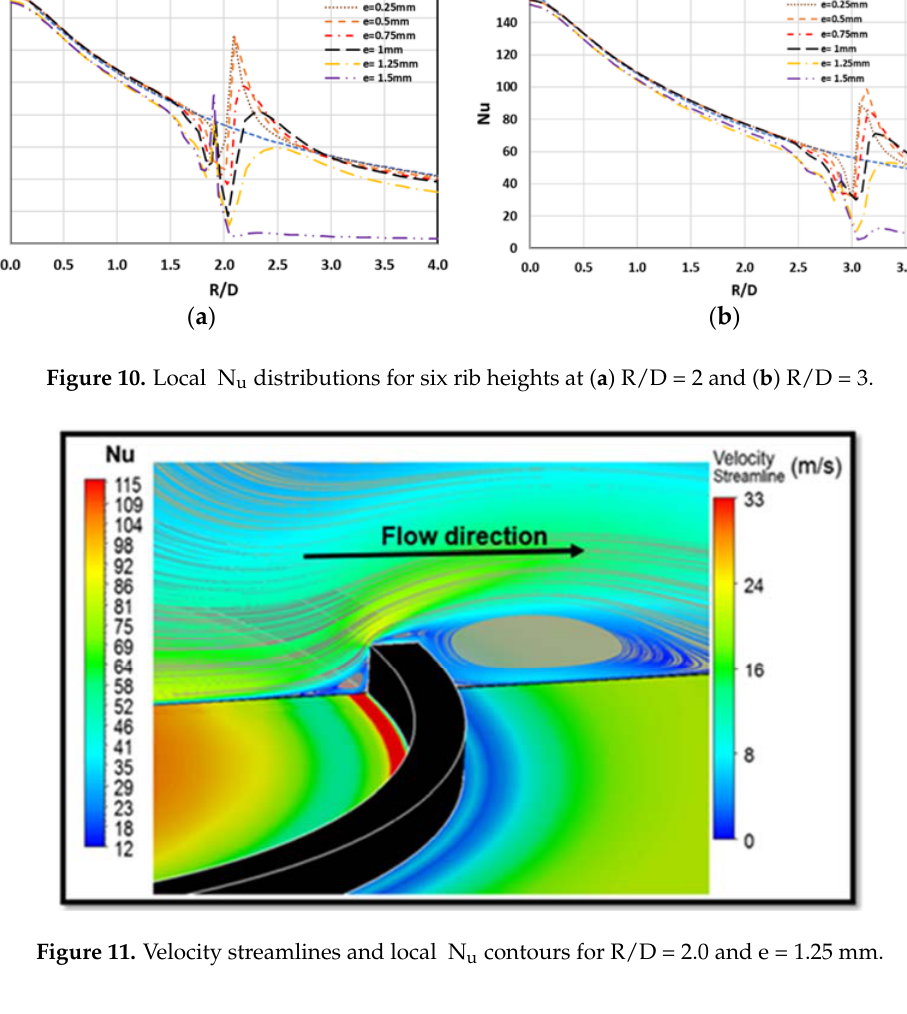
Figure 9. Velocity vectors for e = 1.5 mm. ( a ) R/D = 1 and ( b ) R/D = 1.5. Gau, et al. [28] reported this phenomenon for a 2-D air slot jet impingement on a flat rectangular surface with straight ribs of different heights attached perpendicular to the flow. They explained that the shear layer, while separated from the surface, experiences turbulence effects which enhance momentum and mass (heat) transfer so that its re-attachment to the surface behind the rib results in an increase in heat transfer. After this impingement, the turbulent free shear layer reattaches itself to the surface, and a new boundary layer develops. Thus, placing ribs normal to the flow of the wall jet is an effective means for enhancing total heat transfer rate to/from the wall by disrupting the rather rapid decrease in convective heat transferred to/from the wall. The formation of a boundary layer begins in the stagnation region with a thickness of no more than one-tenth of the jet hydraulic diameter [ 2 6]. The locations R/D = 2 and 3 represent the beginning of the wall jet region [27] where the flow starts to exchange momentum with the wall. The wall jet boundary layer thickness is influenced by both flow velocity gradients with respect to the no-slip wall and with respect to the stationary flow above the jet. The wall shearing layer thickness increases as the flow move downstream, while its average velocity decreases due to momentum exchange with the wall. Depending on the velocity gradients, rib location could have a different impact on the flow physics and heat transfer rate. By comparison with the baseline case, placing the circular rib at R/D = 2 and 3, improves the local N (cid:2931) significantly (see Figure 10). This enhancement is a result of the high turbulence level induced by the flow recirculation before and after the rib. As rib height increases, the distance